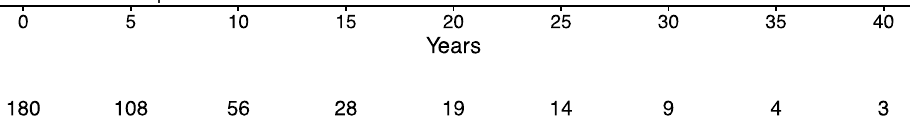
Figure 1. Kaplan–Meier (KMI) estimate of cumulative probability of scoliosis diagnosis in the overall cohort. Dotted line refers to the estimated median time to scoliosis diagnosis, i.e., the time interval for which the probability of getting scoliosis at the end of the interval is 0.5.